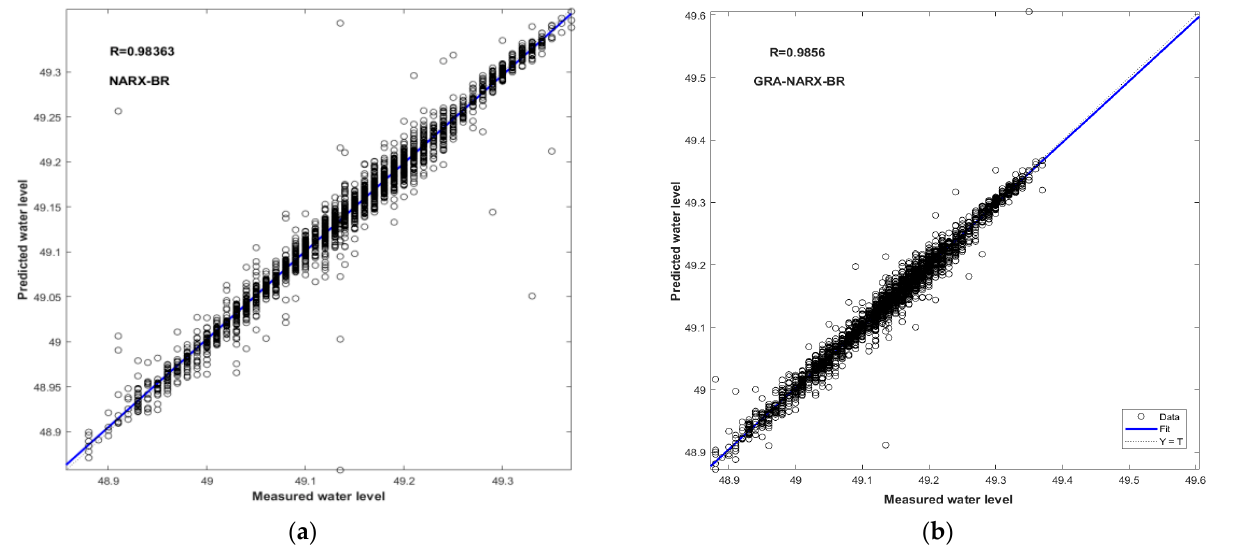
Figure 6. Scatter plots of measured and predicted water levels for the GRA-NARX and NARX models using BR as the training algorithm: ( a ) NARX-BR, ( b ) GRA-NARX-BR.